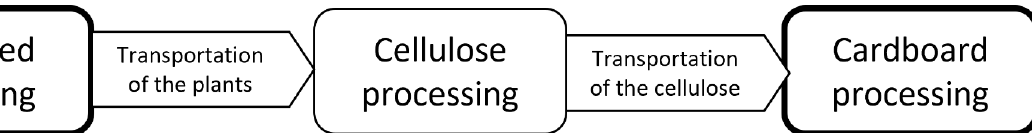
Figure 7. Business model ‘ industrial symbiosis- 1′ .Bold contour highlights processes performed by other organizations (contractors, consumers, etc).